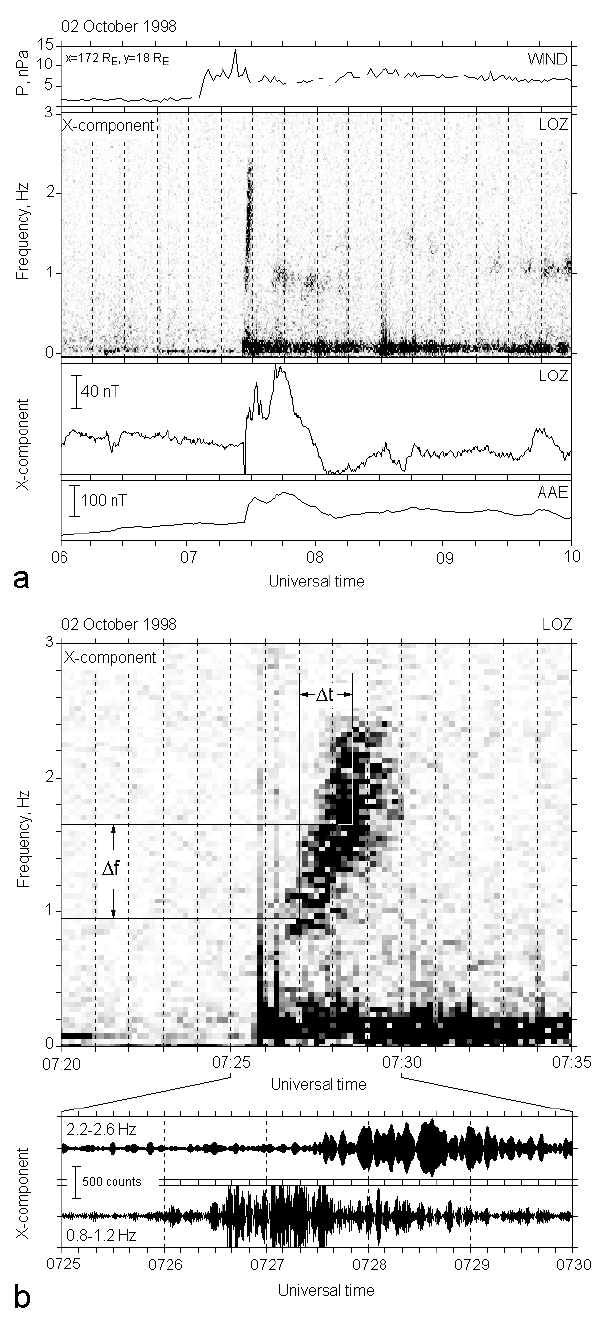
Fig. 3. An example of SB event with the first burst manifested. (a) The same as in Fig. 1. (b) The dispersive characteristics of the first burst (top) and the result of signal filtering in two frequency bands (bottom).